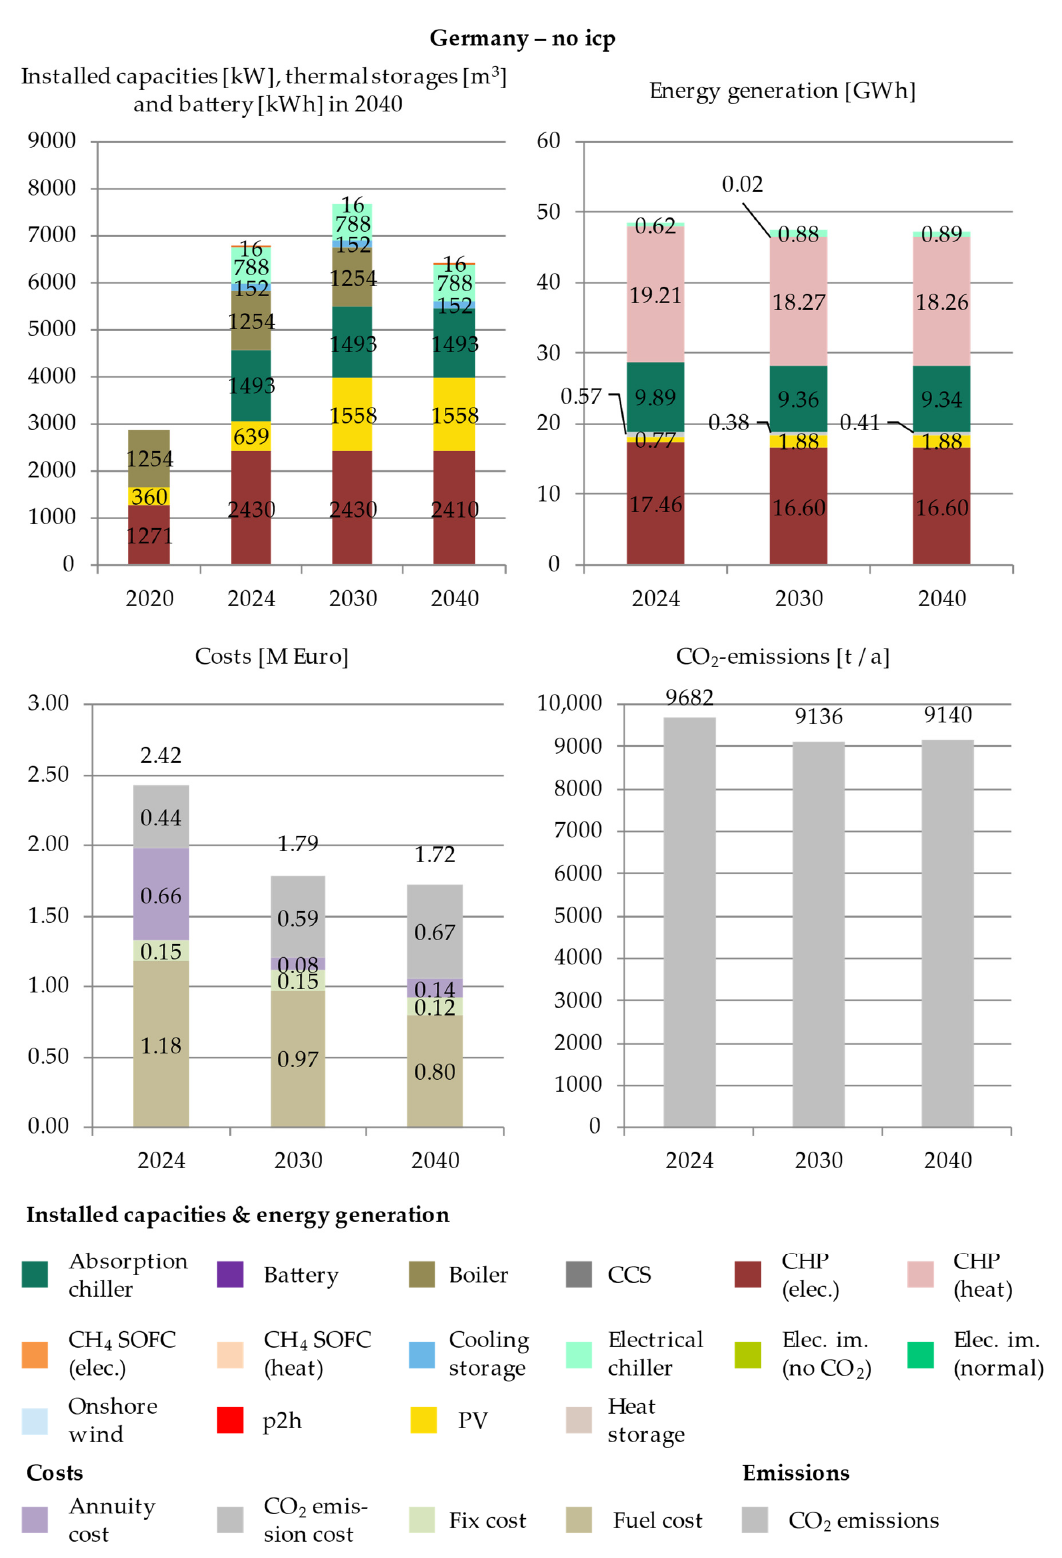
Figure A1. Detailed results for the German “no ICP” scenario.